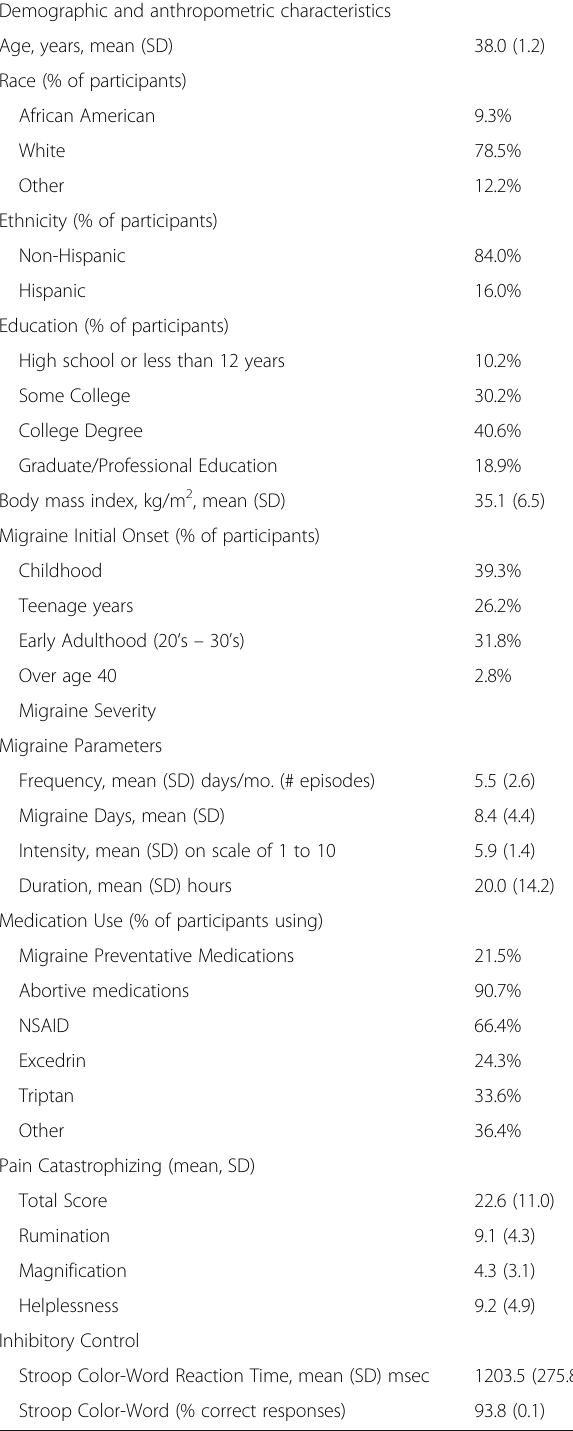
Table 1 Characteristics of the